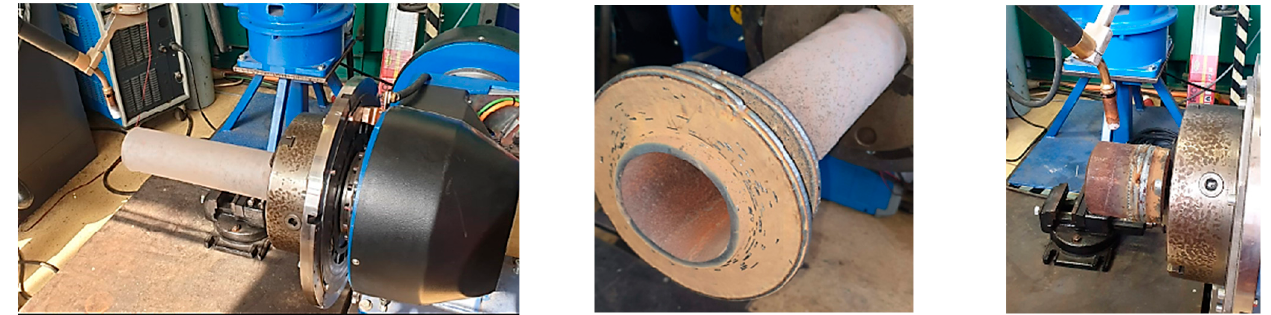
Figure 3. Steps from the working procedure of wire arc additive manufacturing.